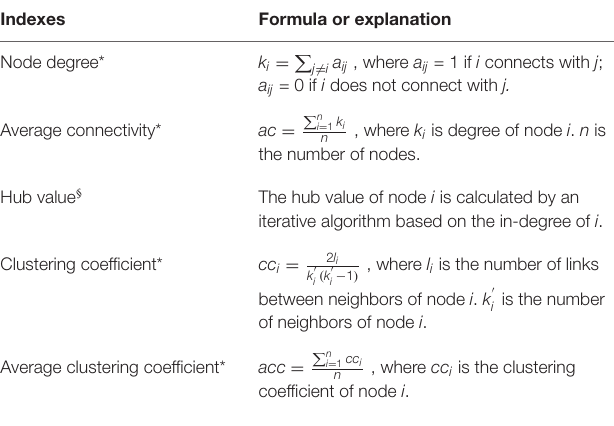
TABLE 2 | Details of the indexes calculated by the network analysis. Indexes